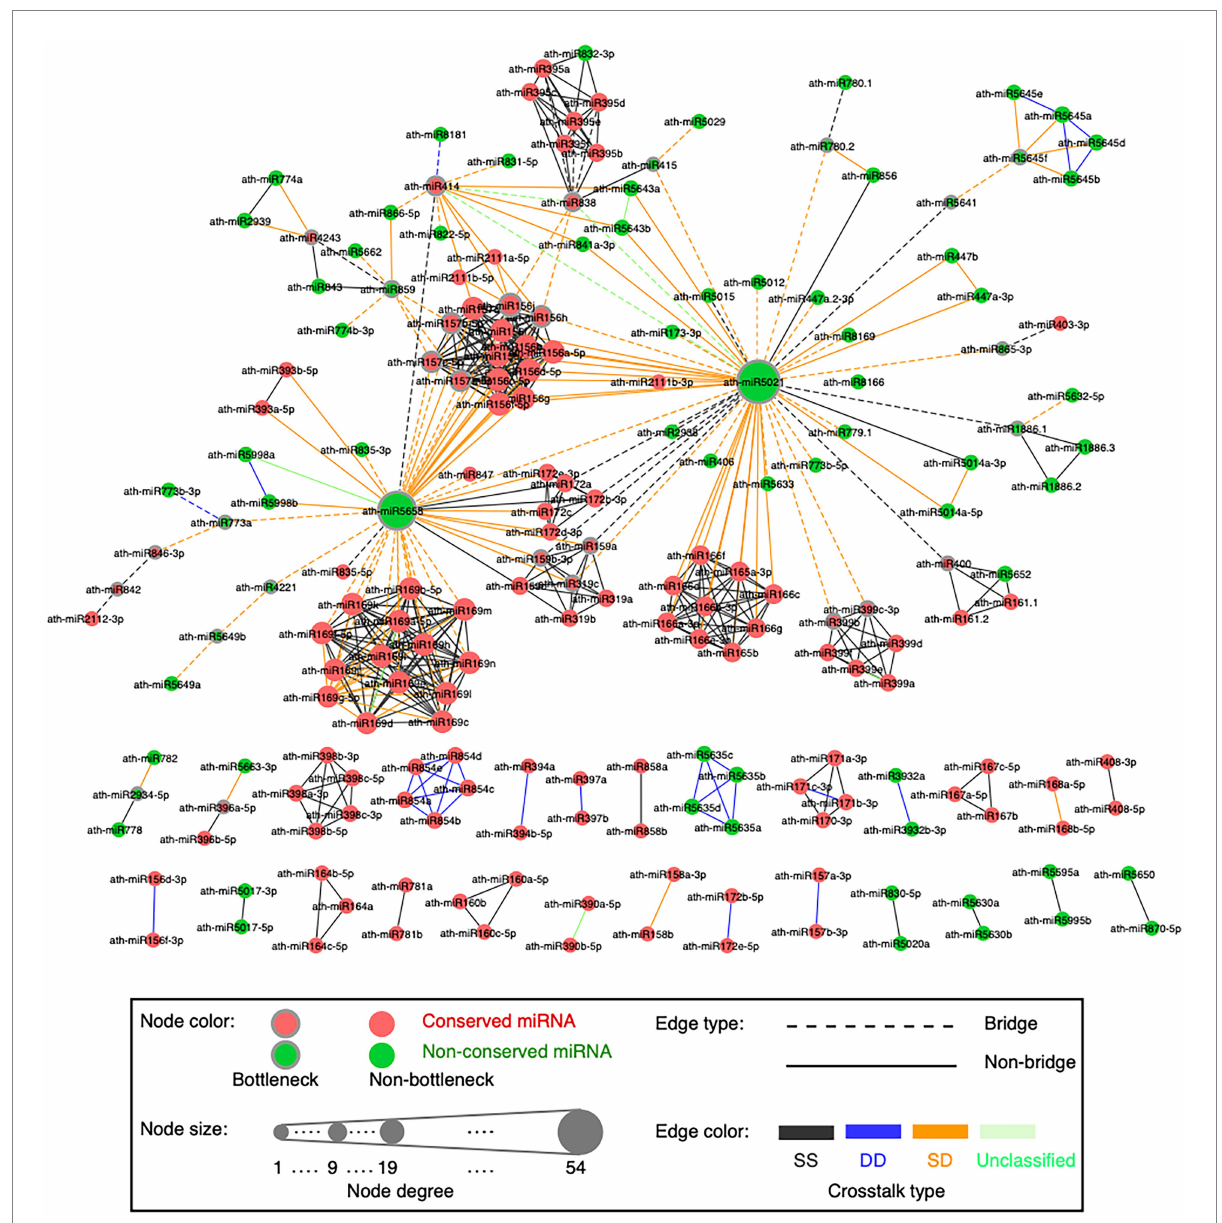
FIGURE 4 Global visualization of the miRNA–miRNA crosstalk network. A circle node represents miRNA. Node size is proportional to the degree of miRNAs. Bottleneck nodes (the top 15% miRNAs with the highest node betweenness values) are in the gray border. Red nodes indicate conserved miRNAs, while green nodes are non-conserved miRNAs. An edge represents crosstalk between two miRNAs. Edges in dotted lines indicate bridges (the top 15% edges with the highest edge betweenness values). Edges are colored according to the crosstalk types, which are SS type in black, DD type in blue, SD type in orange, and unclassified type in light